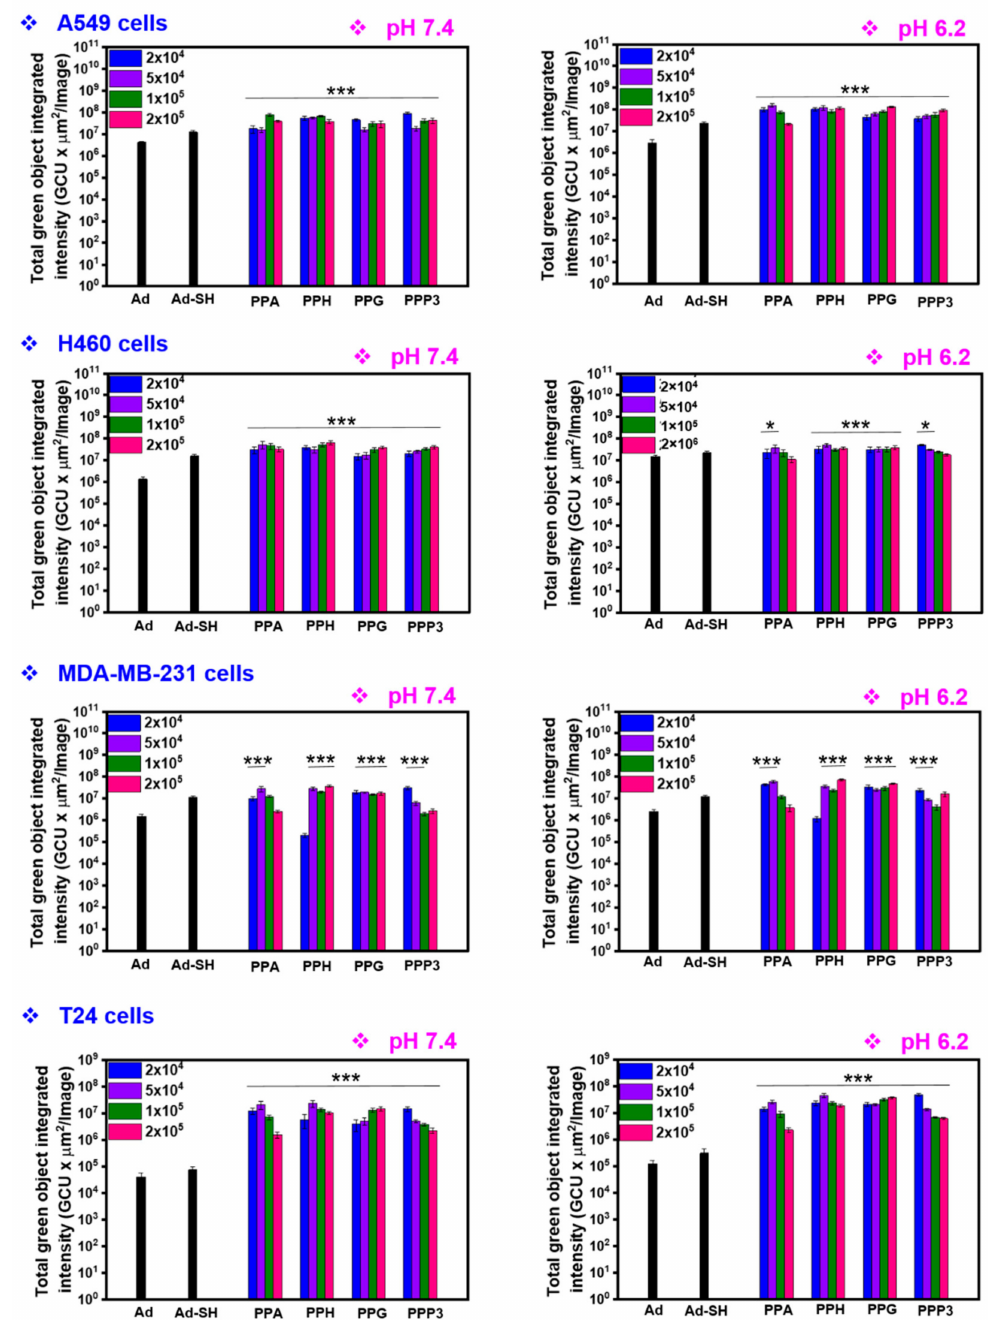
Figure 11. Quantitative analysis of GFP expression from Figure 10. The error bars represent means ± SD ( n = 3). *** p < 0.001 and * p < 0.01 compared with